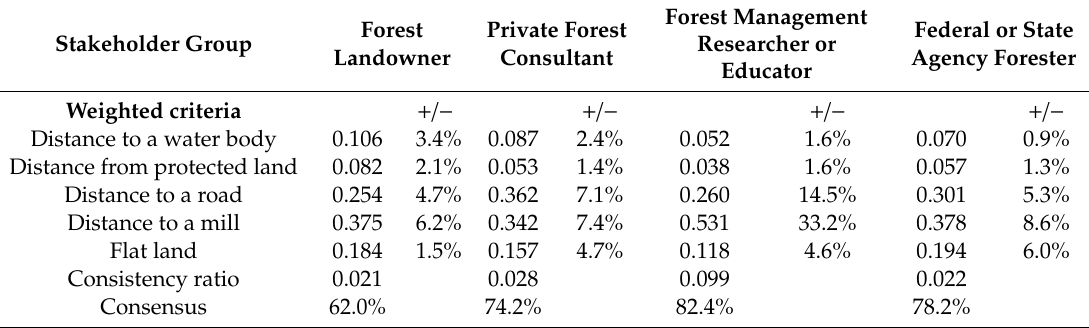
Table 1. Stakeholder groups’ summary of weighted